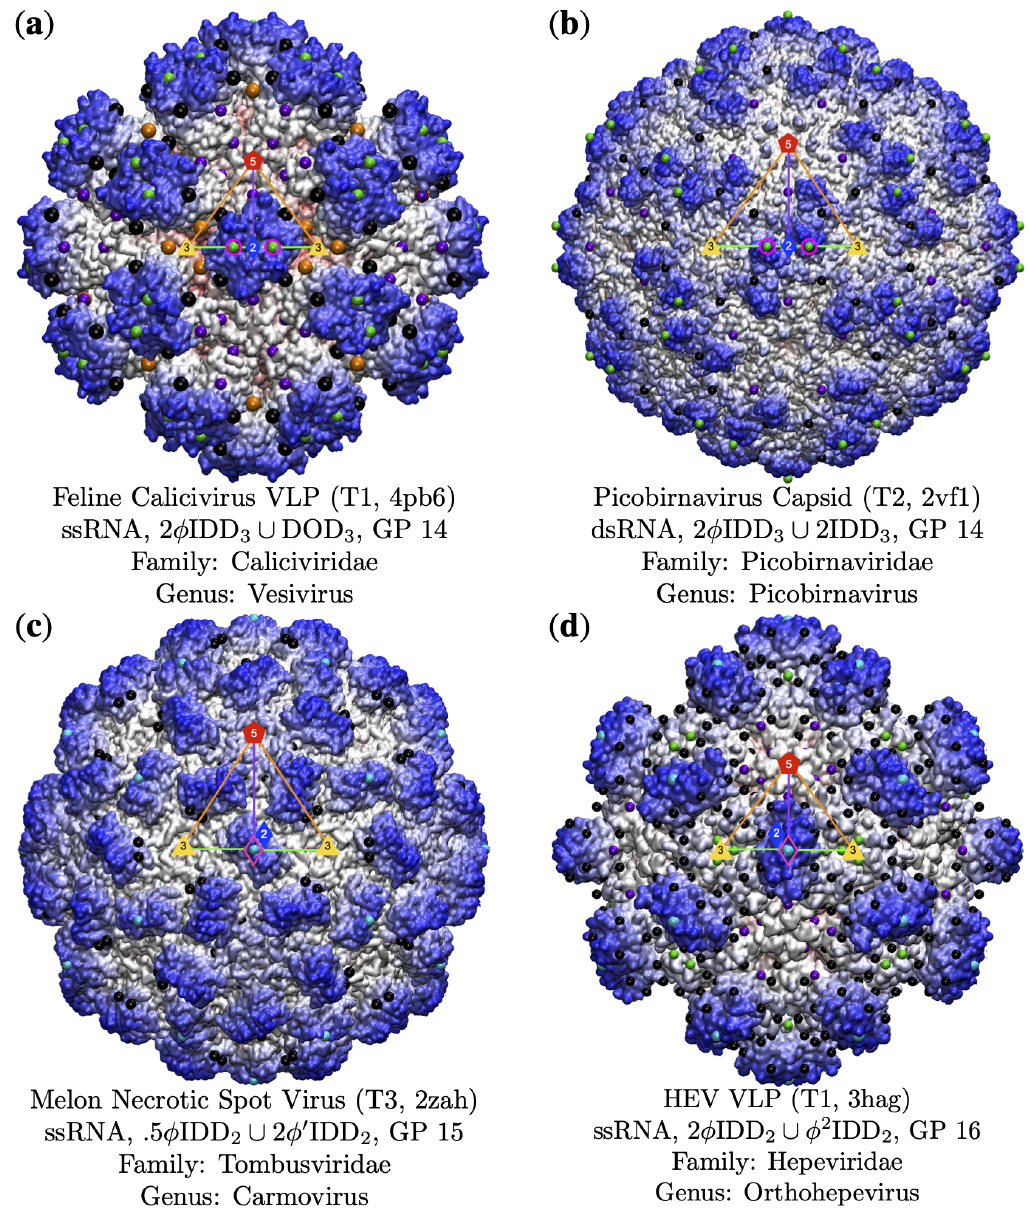
Figure 10. Gauge points 7 to 17 are exclusively RNA viruses. The capsid surfaces are diverse and their protrusions are well located on the gauge points. ( a ) Feline Calicivirus [53] is a VLP with protrusions that flair up near GP 14. ( b ) Picorbirnavirus is a T2 capsid [54] which also uses GP 14, though its surface differs considerably from Feline Calicivirus. ( c ) Melon Necrotic Spot Virus [55] has a structural protrusion at GP 15. There is another protrusion at GP 3; however, none of the associate point arrays fit the capsid well as well. ( d ) Hepatitis E VLP [56] has excellent agreement with its point arrays [3] and uses the 2-fold